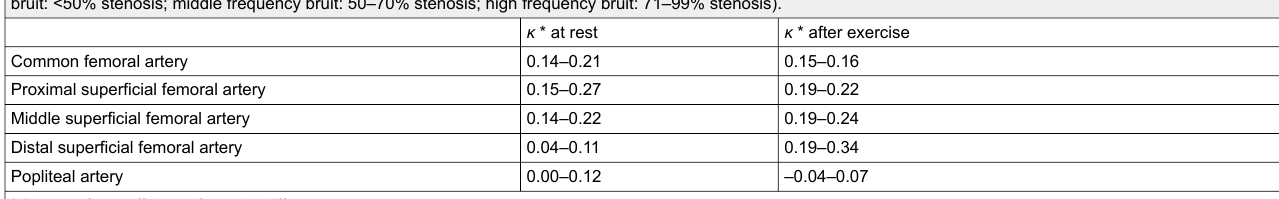
Table 2: Range of Cohen’s κ coefficients for differentiated auscultation by different raters before and after exercise (no bruit: <20% stenosis or occlusion; low frequency bruit: <50% stenosis; middle frequency bruit: 50–70% stenosis; high frequency bruit: 71–99%